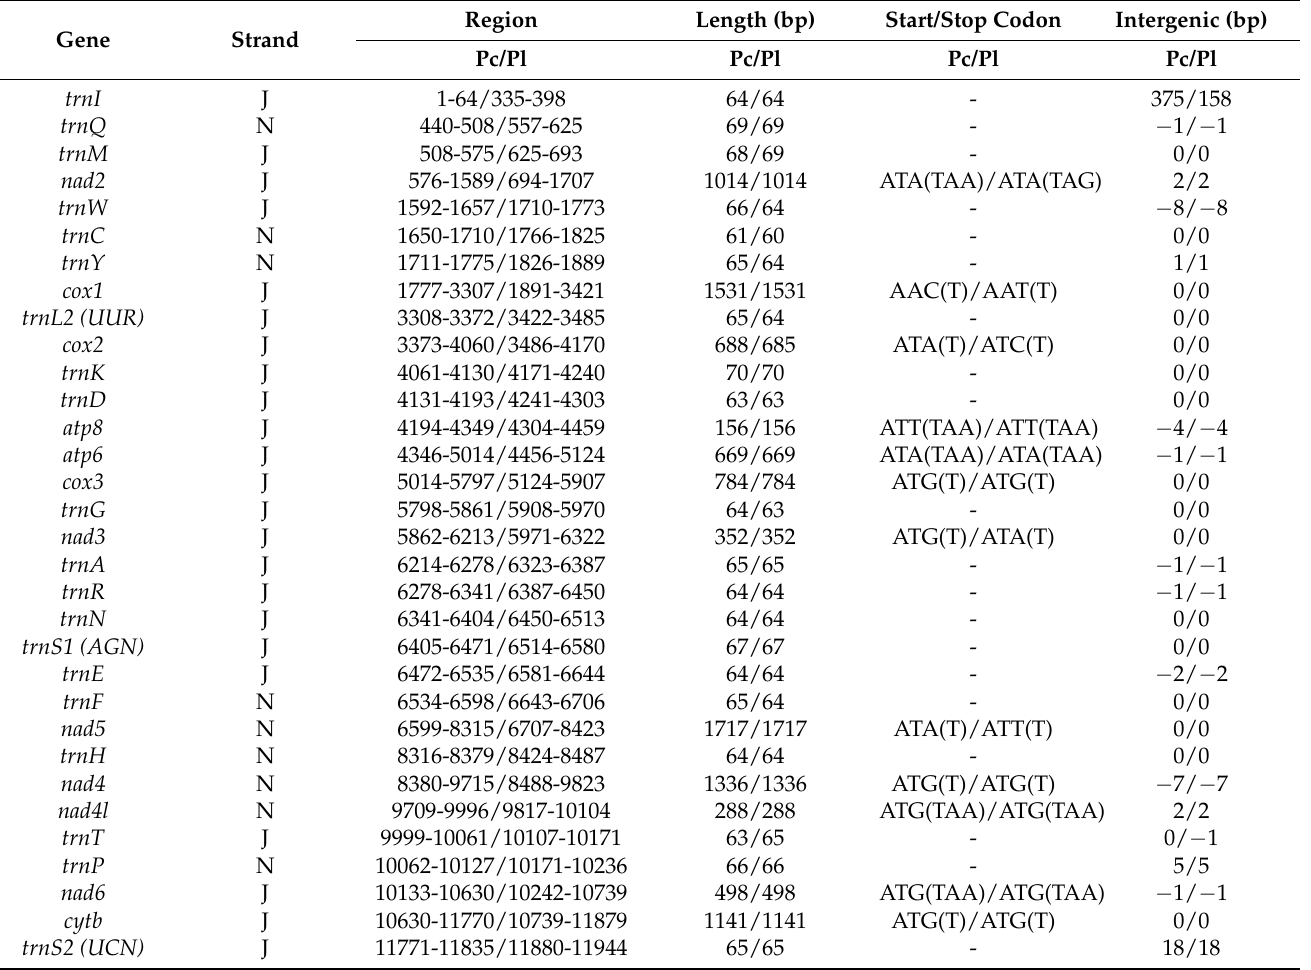
Table 3. Mitogenomic organization of P. castaneus ( Pc ) and P. laterotarsus ( Pl